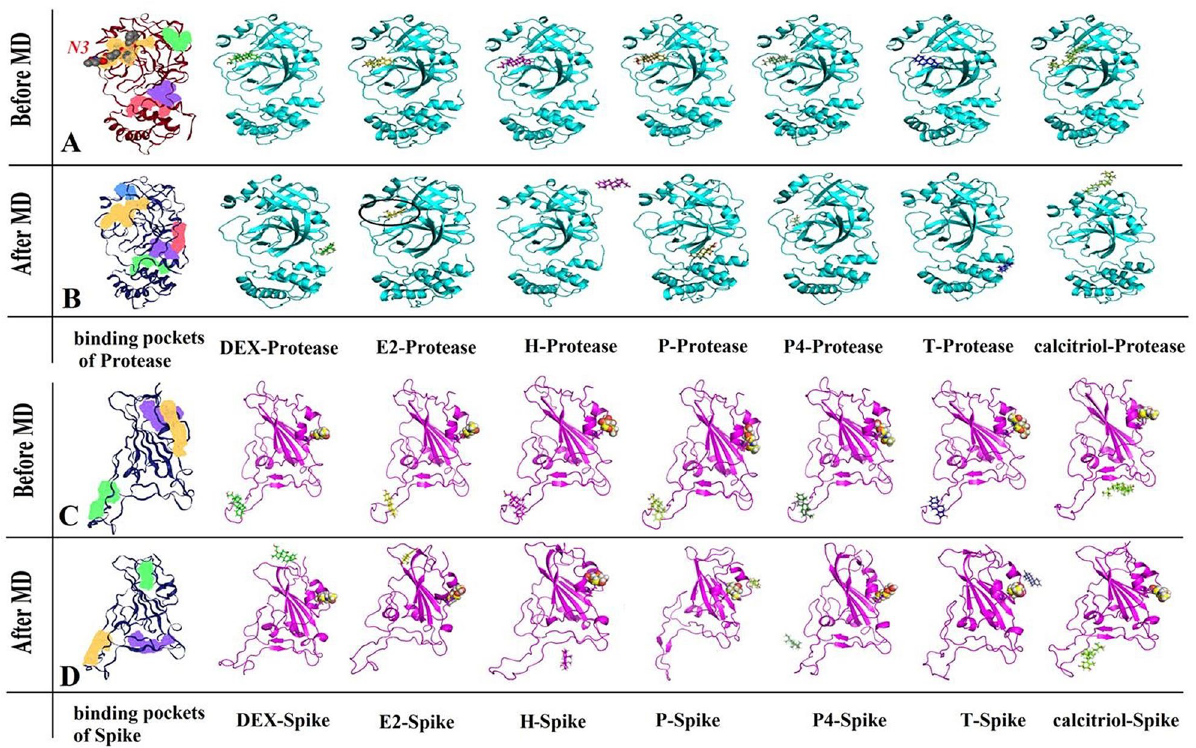
Figure 1. The three-dimensional geometry of the ligand-receptor complex. Best docking geometries (before the MD simulation phase) of steroid molecules on the active site of protease ( A ) or on the contacting sites of the spike protein docking with ACE2 ( C ) and final MD simulation snapshots of steroid molecules on the active site of protease ( B ) or the contacting sites of spike protein with ACE2 ( D ) are shown. Different potential binding pockets of protease and spike protein are shown by yellow (first pocket), violet (second pocket), green (third pocket), red (fourth pocket), and blue (fifth pocket) colors. The glycan linked to receptor-binding domain of spike is represented by ball. Inhibitor N3 is found at the active site of the protease. DEX, dexamethasone; P4, progesterone, T, testosterone, E2, estradiol; H, hydrocortisone; P,